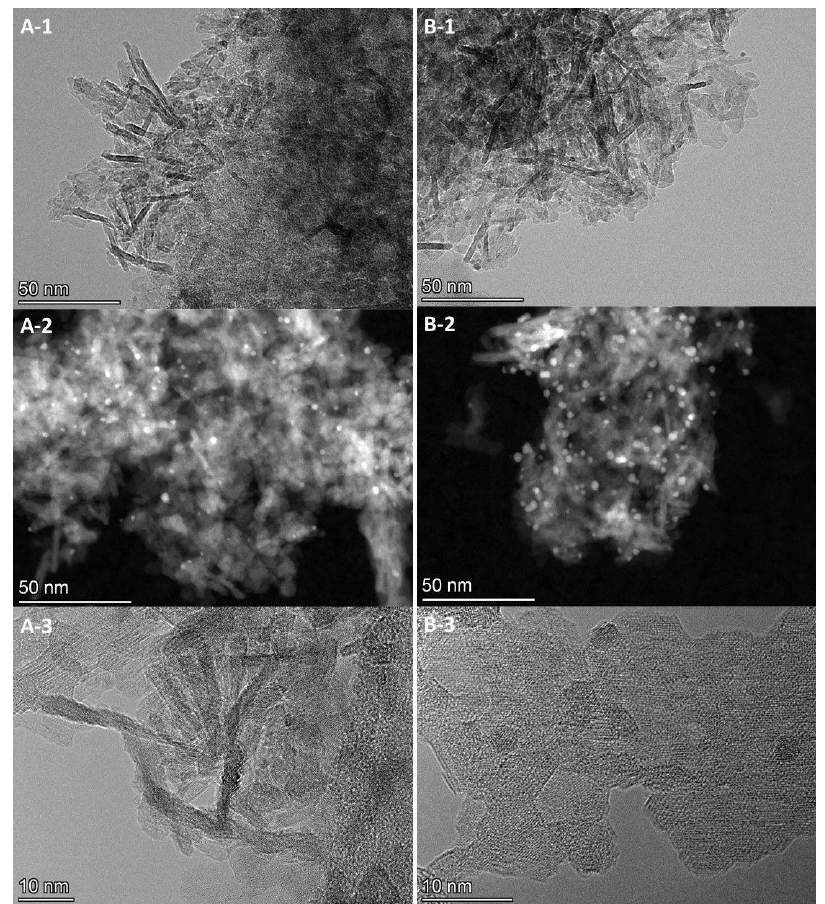
Figure 2. HRTEM images of 1 wt.% Pd/γ -Al 2 O 3 : ( A1 – A3 ) series for PdA-WI-Cl; ( B1 – B3 ) series for PdA-WI-N. A1 и B1 — HAADF images of the corresponding catalysts